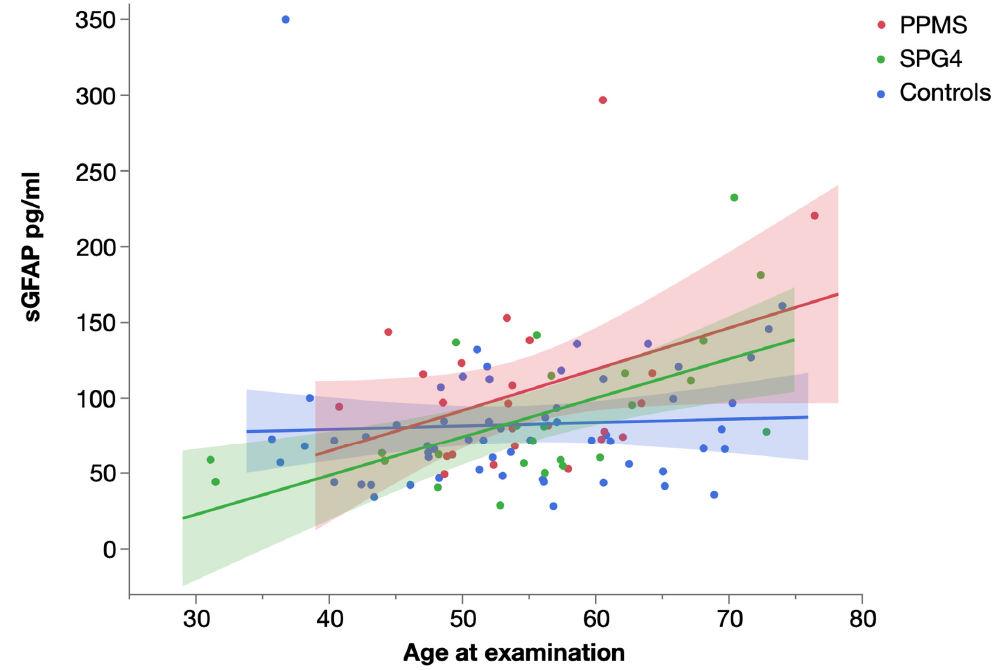
Figure 5. Scatter plot of serum GFAP levels in PPMS, SPG4 and controls by age, with linear fit. Shaded areas represent 95% confidence intervals.